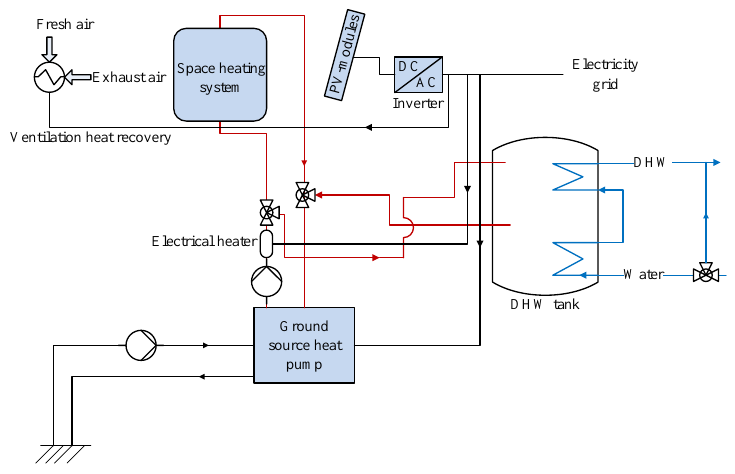
Figure 3. System schematics for the building with GSHP and PV system.